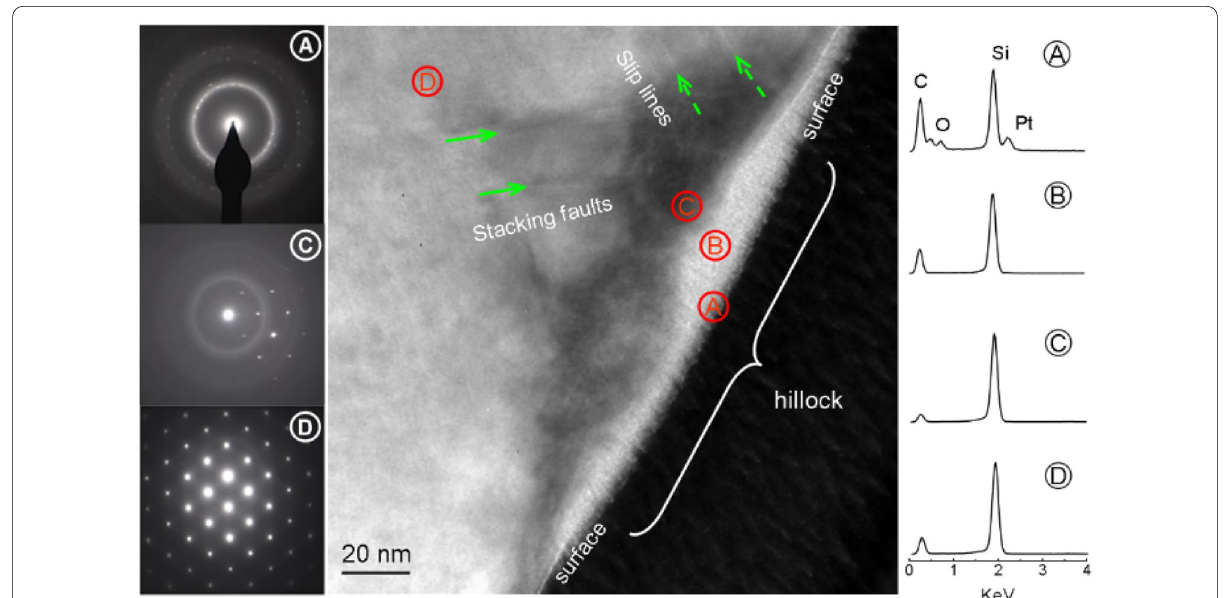
Figure 8 XTEM image showing the cross-sectional structure of a typical hillock formed on Si(100) surface [24] (The left pictures show the SAD patterns from areas: A—amorphous rings for the hillock (sharp rings from Pt), C—deformed and amorphous silicon, and D—substrate silicon (b 110). The right pictures show the EDX spectra from different marked areas of the cross-section)